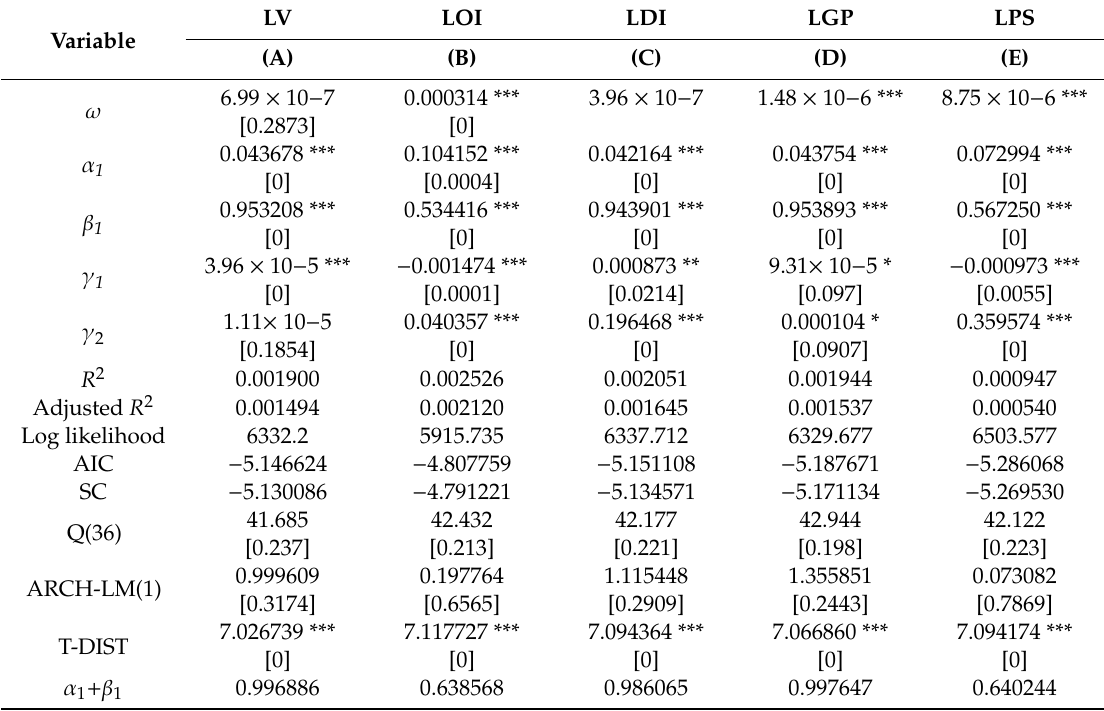
Table 14. Estimation results of the influence of various factors on the fluctuation of Brent crude oil